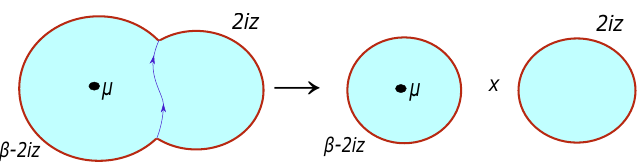
Figure 21 . Wilson line representation for the metric. For z parametrically large, the Wilson line pinches o(cid:11) two disk-shaped regions which e(cid:11)ectively decouple as in (D.14).